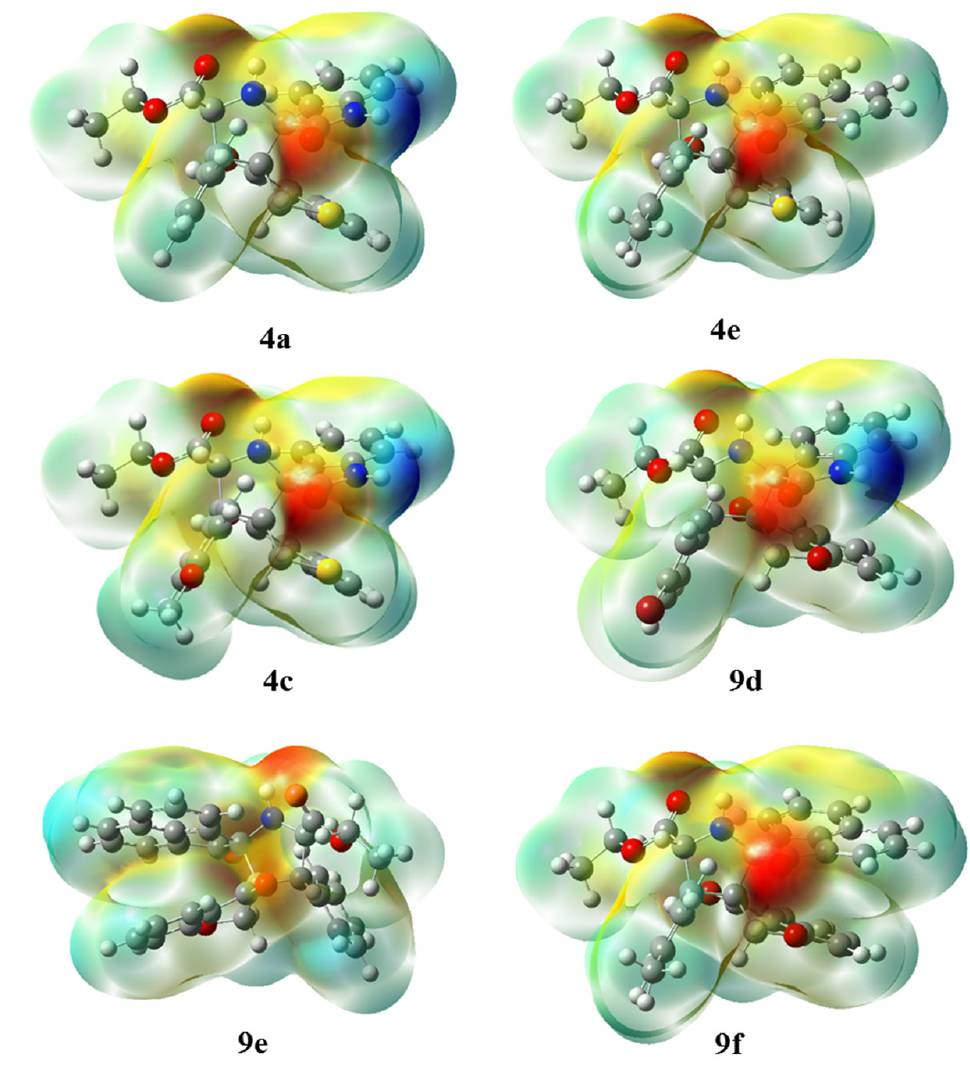
Figure 7. Molecular electrostatic potential (MEP) formed by mapping of the total density over the electrostatic potential for compounds 4a , 4e , 4c , 9d , 9e , and 9f .